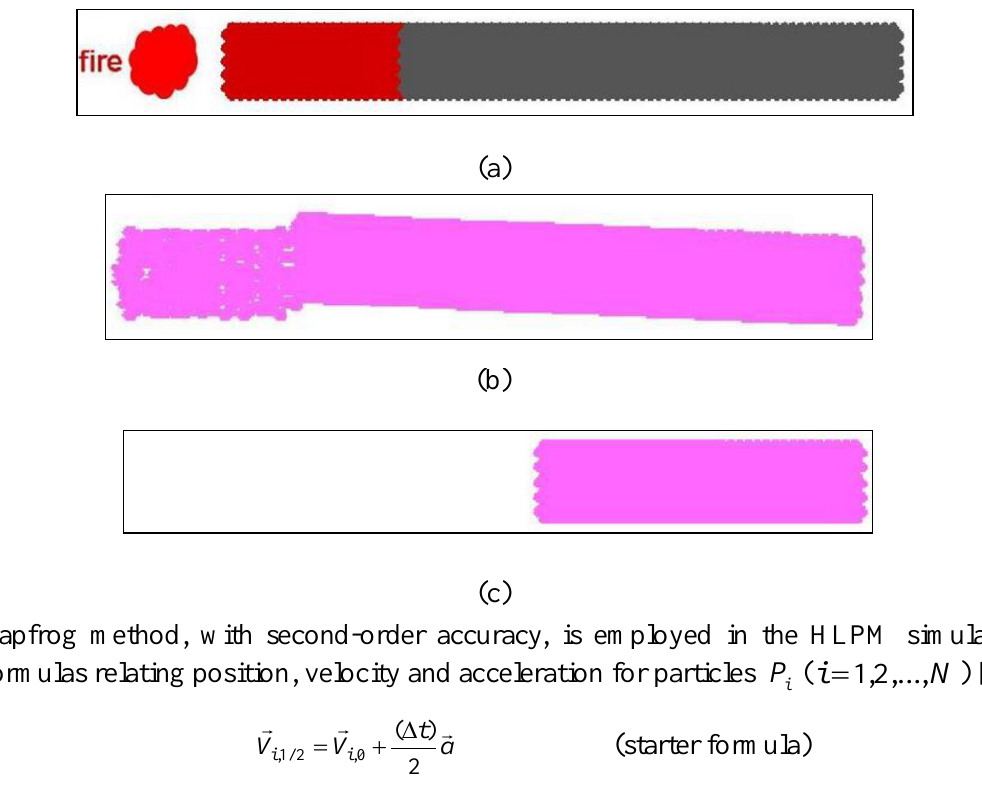
Figure 6. HLPM fire resistance study of structure, (a) problem description, (b) with